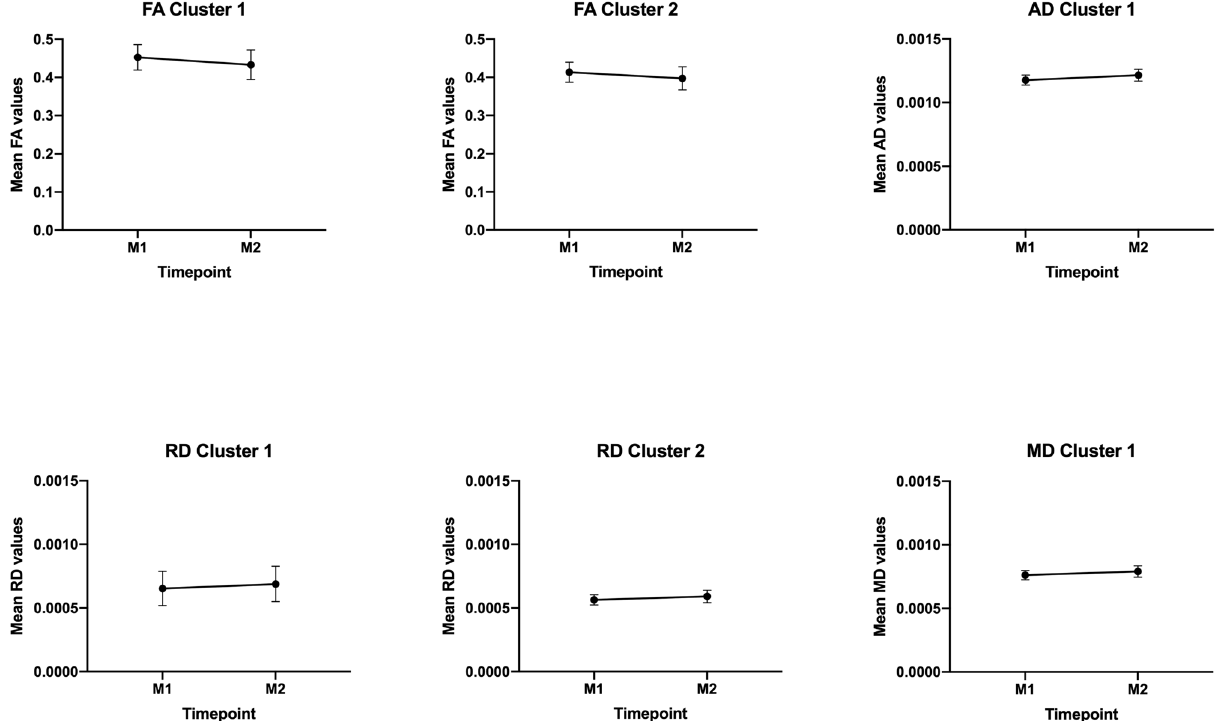
Figure 2. Trajectories of DTI metrics (FA, AD, RD and MD) of each cluster with significant differences between timepoints. The x-axis represents time of assessment and y-axis, the average values of each metric. Error bars represent standard deviation. FA clusters show a decrease along time, while AD, RD and MD clusters exhibit an increase. Overall, these results suggest that aging induces a deterioration of white matter integrity.